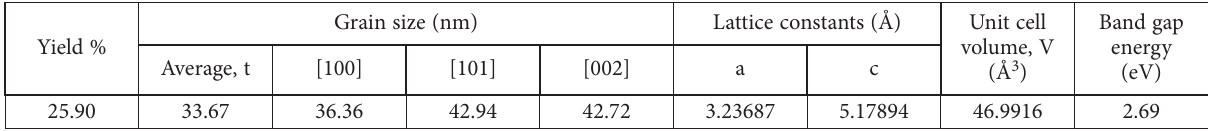
Figure 1. Schematic diagram for the experimental set up Table 1. Characteristics of the Fe-doped ZnO